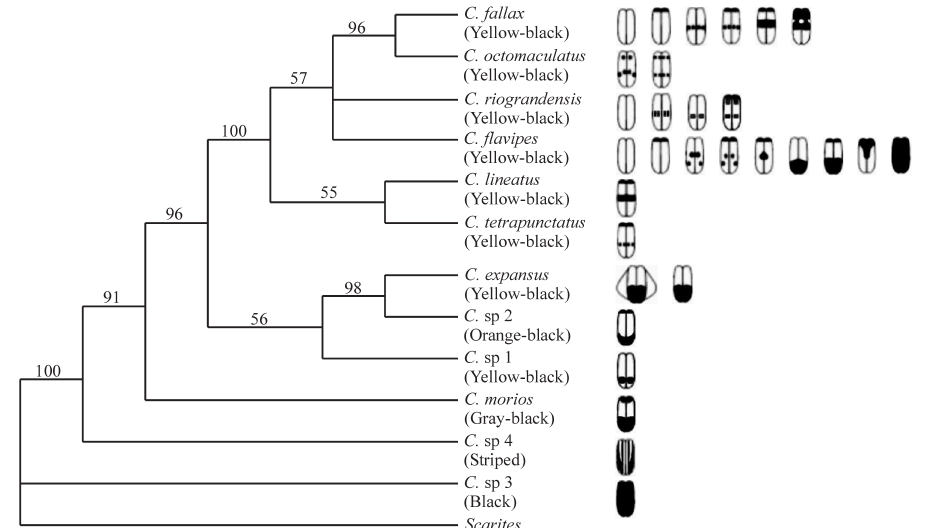
Figure 1 - Single most parsimonious tree obtained with heuristic search re-weighted by maximum value of re-scaled consistency index for the twelve speciesof Chauliognathus .Bootstrapvaluesfor500replicatesaregivenatthenodes.Patternofvariationfoundintheelytracolourforthe12speciesana- lysed of the genus Chauliognathus are figured to the